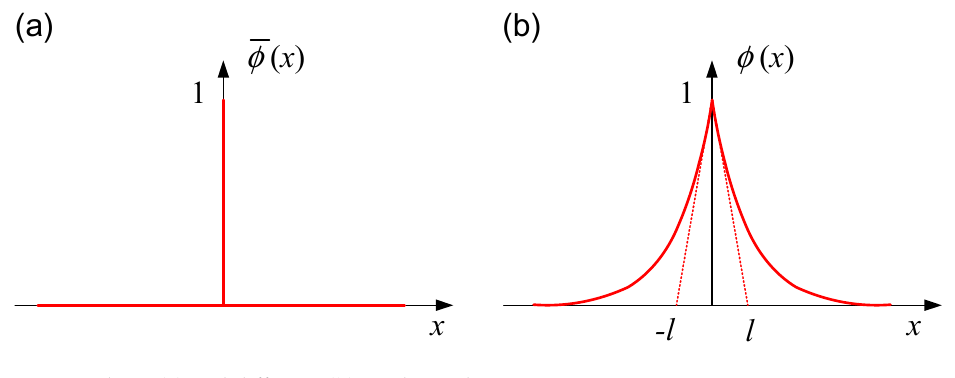
Figure 2. Sharp ( a ) and diffusive ( b ) crack topologies.